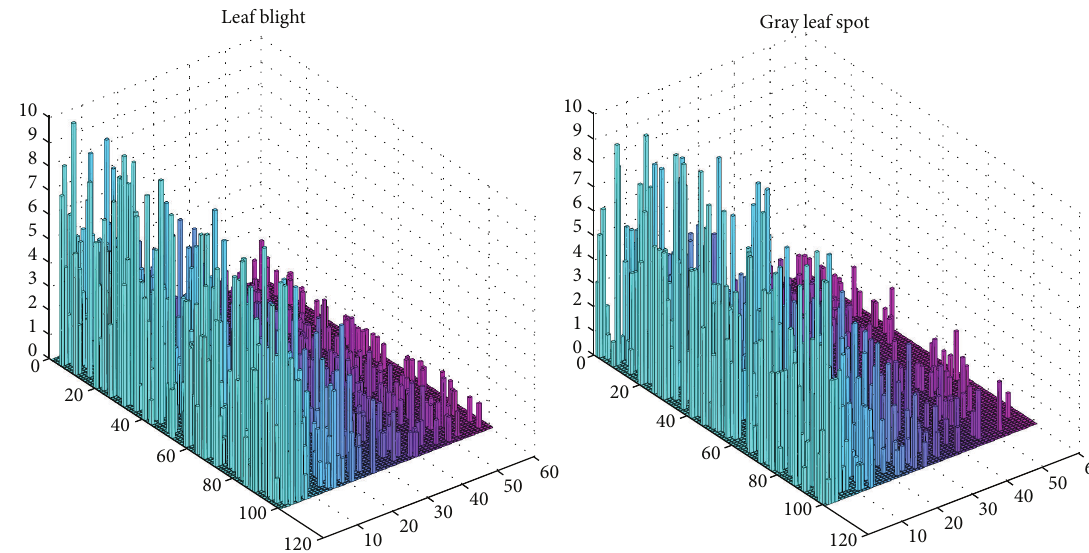
Figure 11: Feature extraction results of Gray leaf spot and Leaf blight disease.